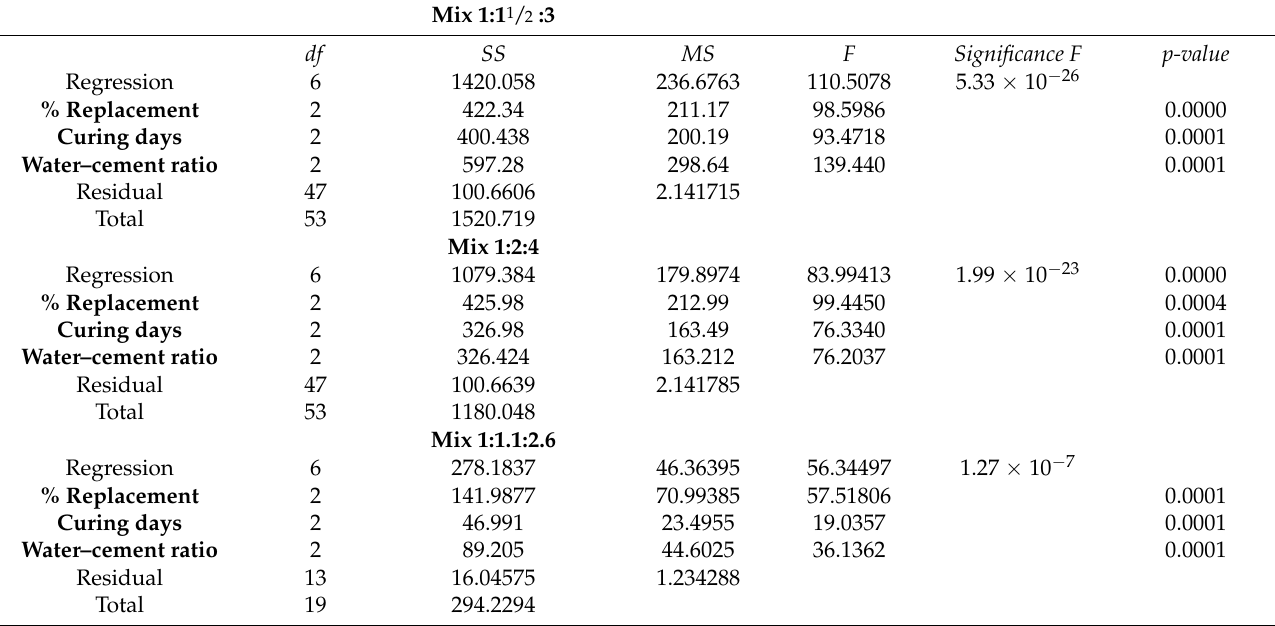
Table 4. ANOVA for the compressive strengths of cement-metakaolin